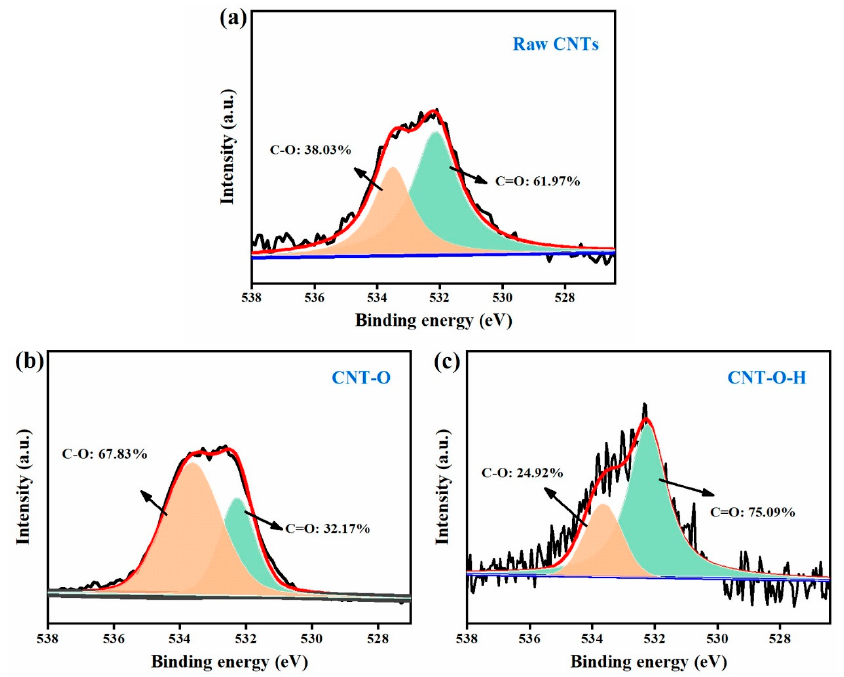
Figure 4. O 1s spectra of raw CNTs ( a ), CNT-O ( b ) and CNT-O-H ( c ).